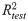
Augmenting with scores at different assay conditions did not improve predictions.At 15% mutational completeness, the data size was augmented by combining data from six different assay conditions. There was no improvement in the prediction quality although the data was enhanced 6-fold. The Rtest2 with and without data augmentation was 0.61 and 0.66 respectively. More detailed results are in Fig 10 in S2 File. Similar analysis was performed by developing model trained on data from the 650 μg/ml drug concentration assay. In this case also the predictive ability of the models trained at only one concentration or at multiple concentrations was similar.